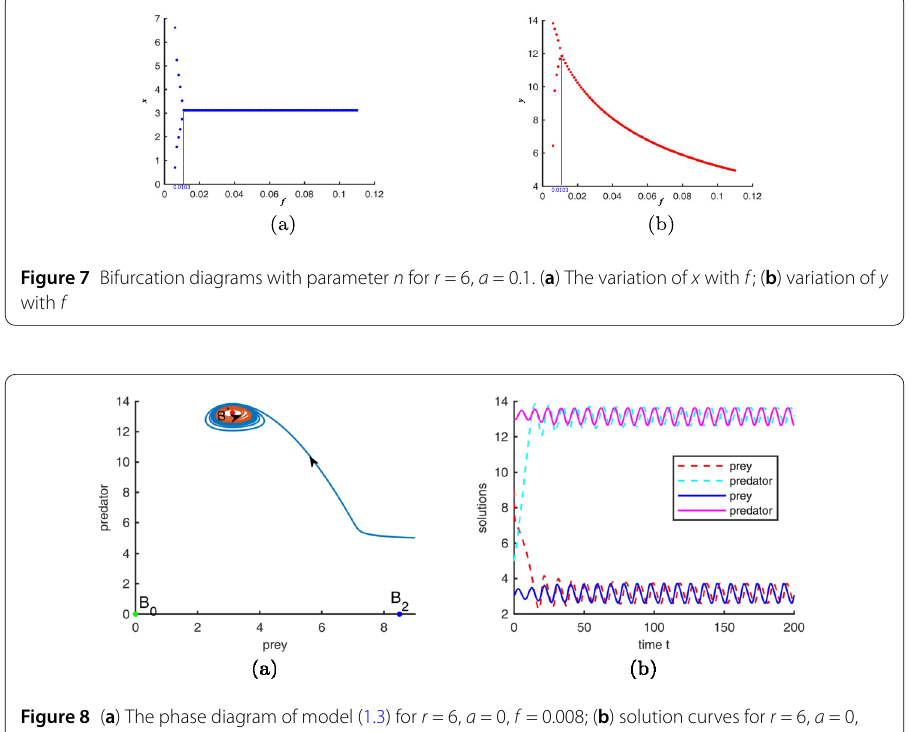
Figure 8 ( a ) The phase diagram of model (1.3) for r = 6, a = 0, f = 0.008; ( b ) solution curves for r = 6, a = 0, f = 0.008. The initial values are (3,13),